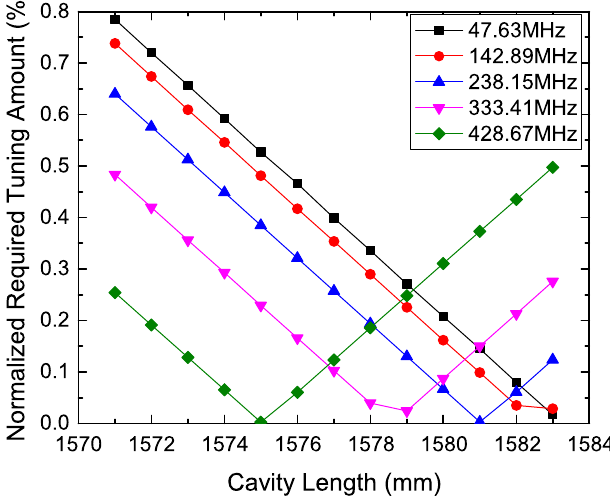
FIG. 6. The cavity schematic model (top) and the equivalent circuit of this capacitor loaded QWR cavity (bottom).